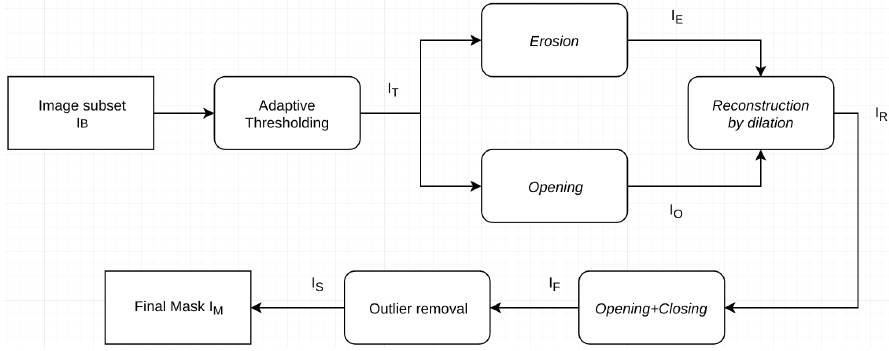
Figure 2. Flowchart of the proposed processing